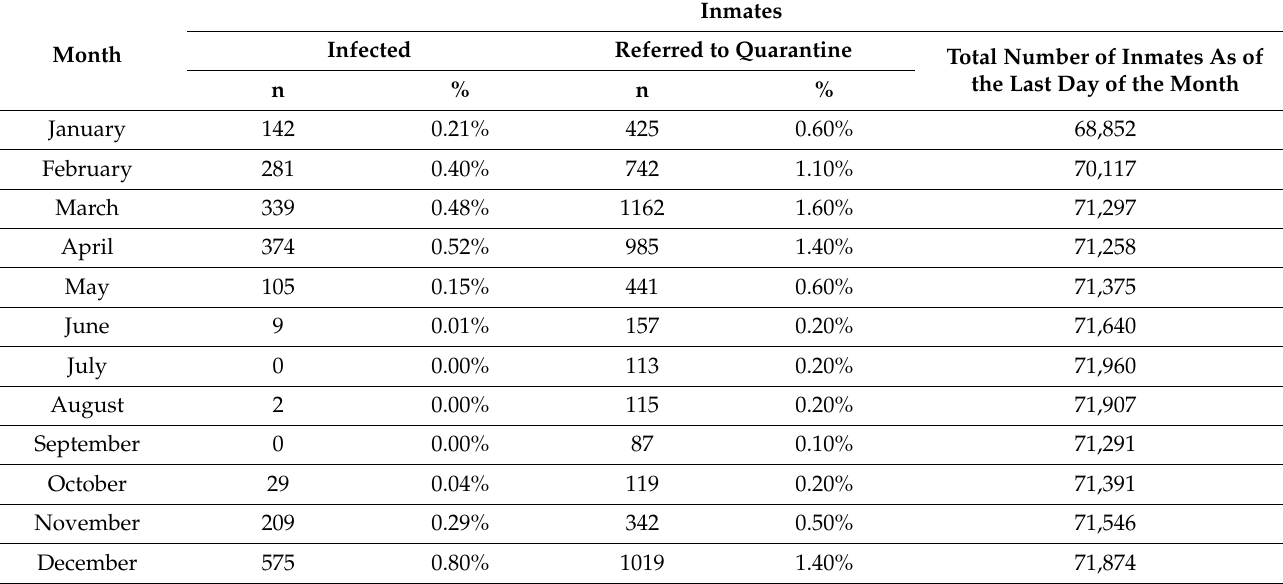
Table 1. Number of infected prisoners referred to